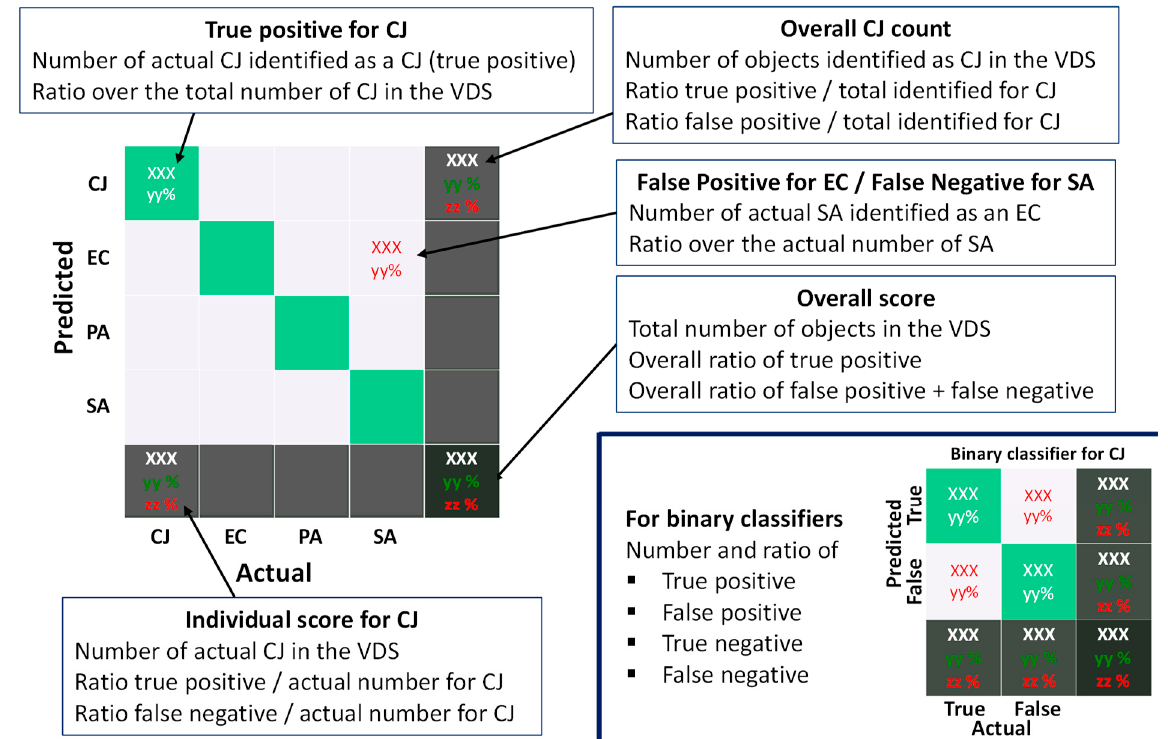
Figure 2. Description of the way how confusion matrices have to be interpreted in the case of binary classifiers (bottom-right) or the 1-over-4 classifier.